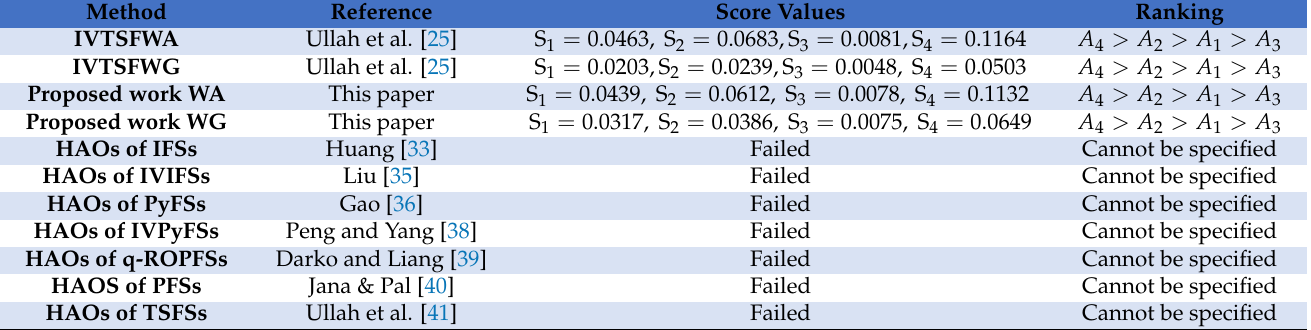
Table 6. Ranking of alternatives using existing and proposed methods.